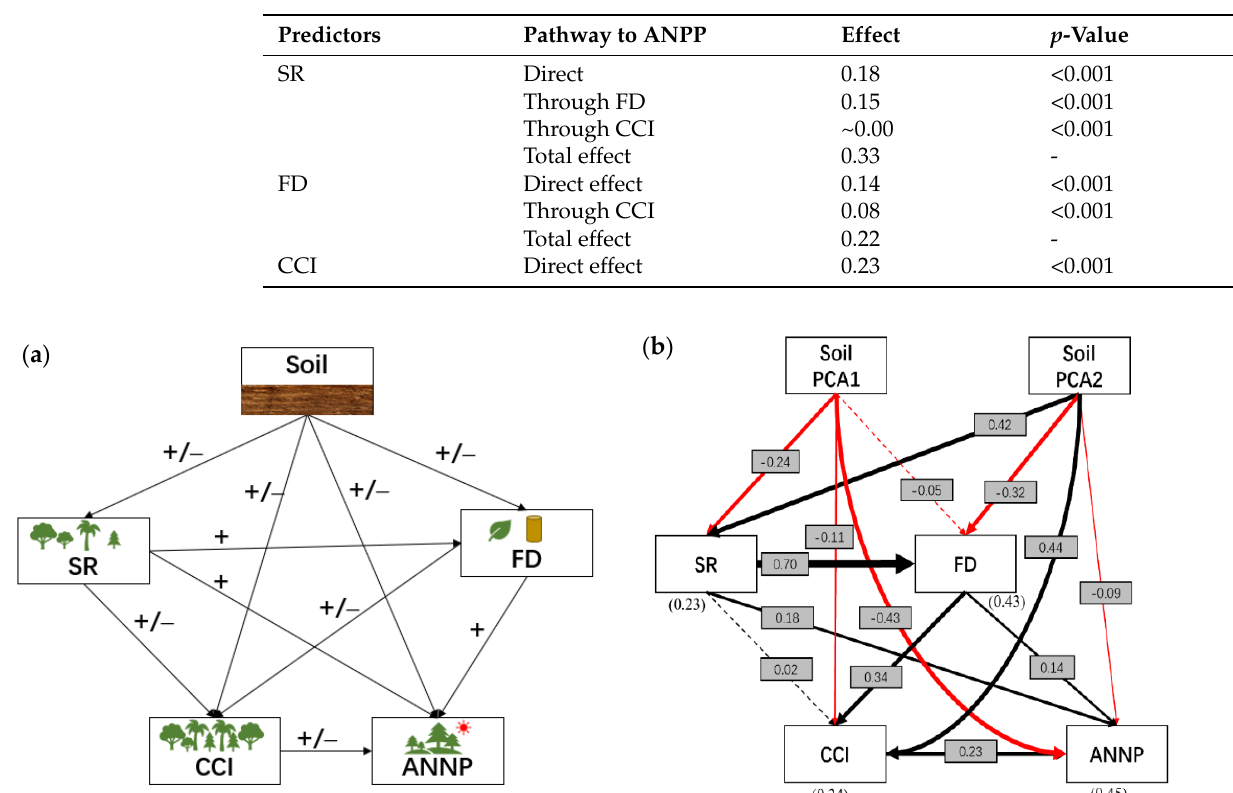
Figure 5. Structure equation models linking species richness and annual forest productivity. ( a ) Conceptional diagram for examining the SRPRs in a subtropical forest; ( b ) model consisting of soil variables, species richness, crown complementarity index, functional diversity, and annual forest productivity. Numbers on the arrows indicate standardized path coefficients. Solid lines and dotted lines indicate significant and non-significant path correlation, respectively. Black and red lines indicate positive and negative path correlations, respectively. R 2 indicates the total variation in an endogenous variable explained by the exogenous variables. Table 2. The direct, indirect and total standardized effects on ANPP based on structural equation models (SEMs).